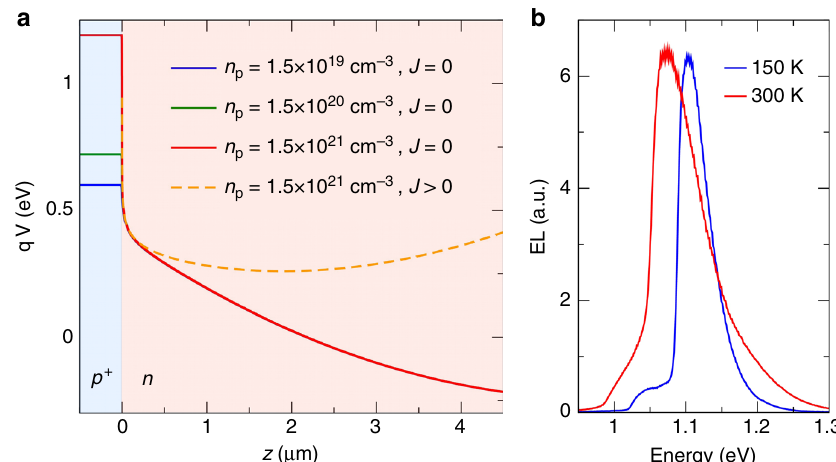
Fig. 2 Origin of enhanced emission in gas immersion laser doping silicon light-emitting devices. a Simulated electrostatic potential at the p + / n interface as a function of the vertical distance z to the p + / n interface. Full curves show different p + doping levels without external bias. The dashed curve shows the formation of a potential minimum under forward bias at a current density of J = 2 × 10 4 Am − 2 for the highest doping level. b Emission spectra from a lateral device with 1.2 × 10 21 cm − 3 doping